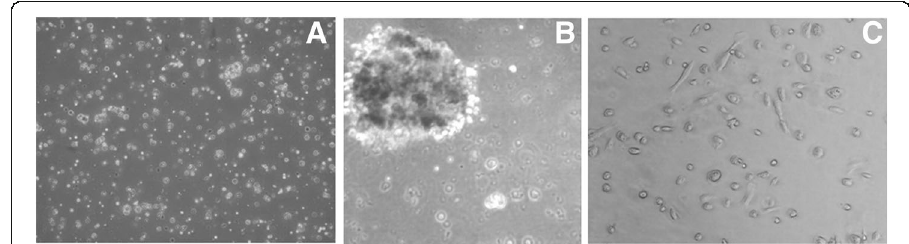
Fig. 2 Morphology of the breast milk-derived cells. a Heterogeneous cell population including leukocytes. b Mammosphere created by hBSCs on Matrigel (on day 8 after isolation). c Subpopulation of lactocytes and myoepithelial cells on day 2 after isolation, culture in vitro on tissue culture